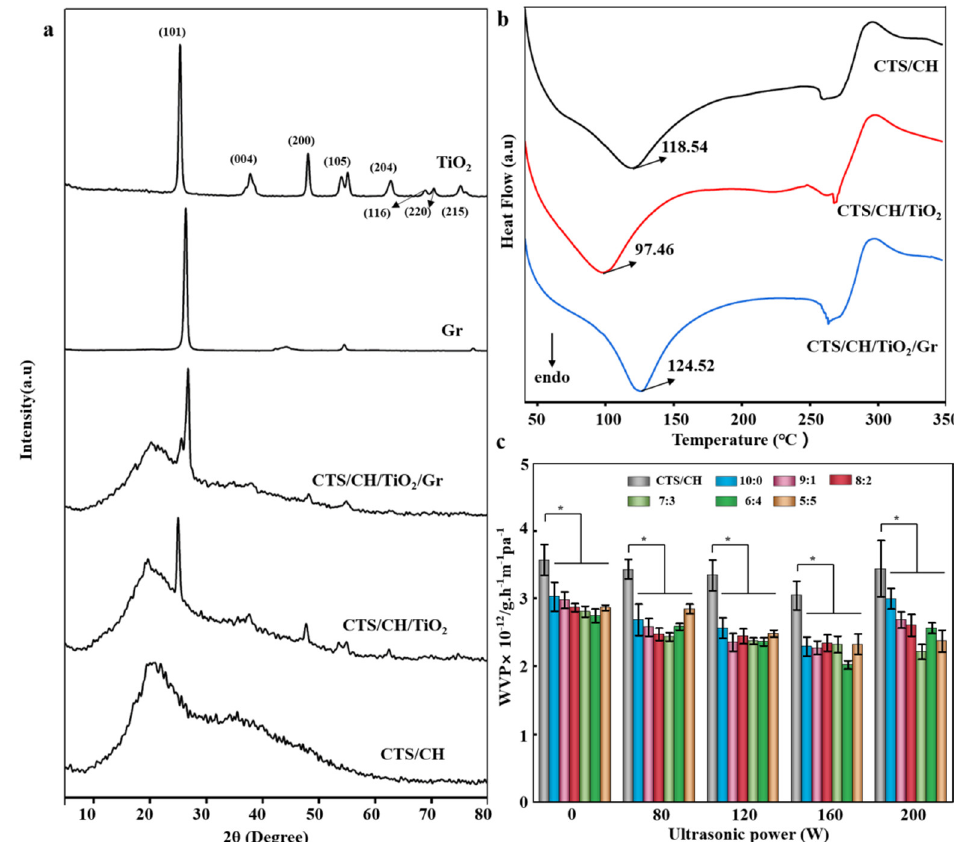
Figure 3. ( a ) XRD patterns of TiO 2 , Gr, and the CTS/CSH, CTS/CSH/TiO 2 , and typical CTS/CSH/TiO 2 /Gr composite films (TiO 2 :Gr = 5:5, ultrasonication power: 160 W); ( b ) DSC thermo- grams of the pure CTS/CSH, CTS/CSH/TiO 2 , and CTS/CSH/TiO 2 /Gr (TiO 2 : Gr = 6:4) composite films fabricated at an ultrasonication power of 160 W; ( c ) WVPs of the CTS/CSH, CTS/CSH/TiO 2 , and CTS/CSH/TiO 2 /Gr composite films fabricated at various ultrasonication powers. * p < 0.05. The peak at 2 θ = 54.62° corresponds to the Gr (004) plane. The XRD pattern of the